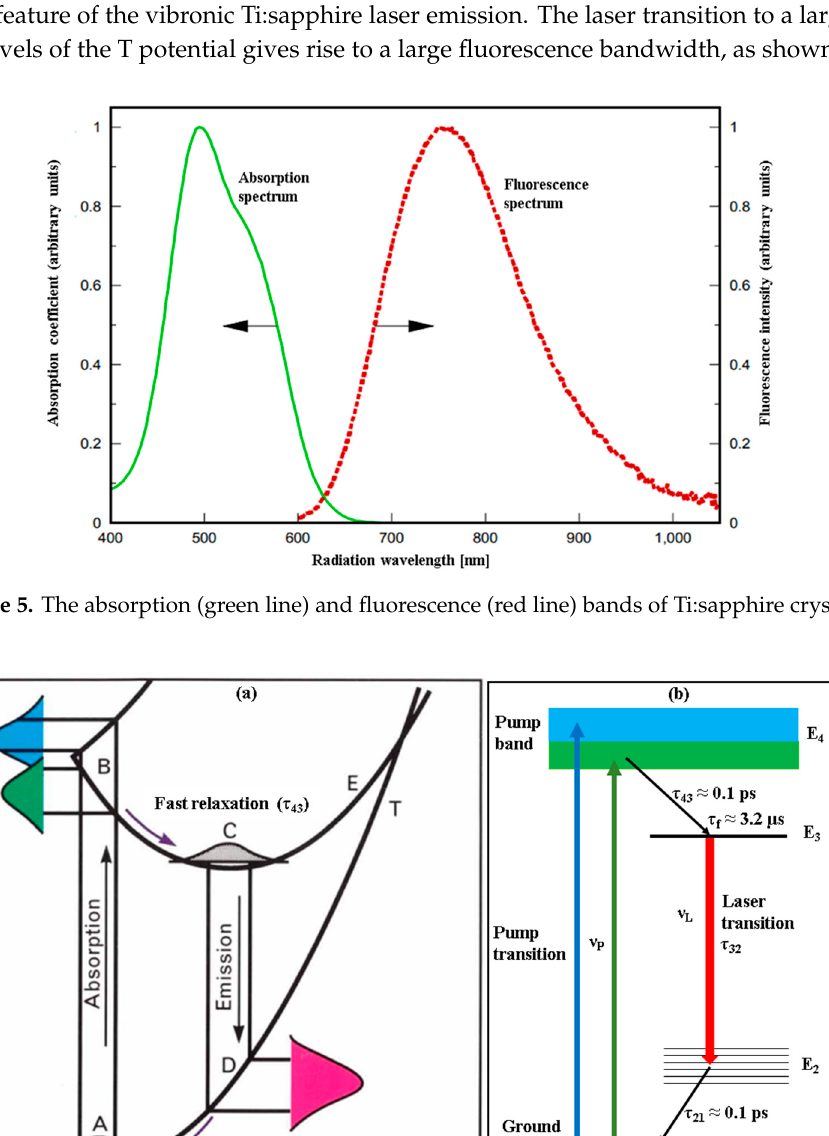
Table 2. The properties of Ti 3+ :sapphire crystals.